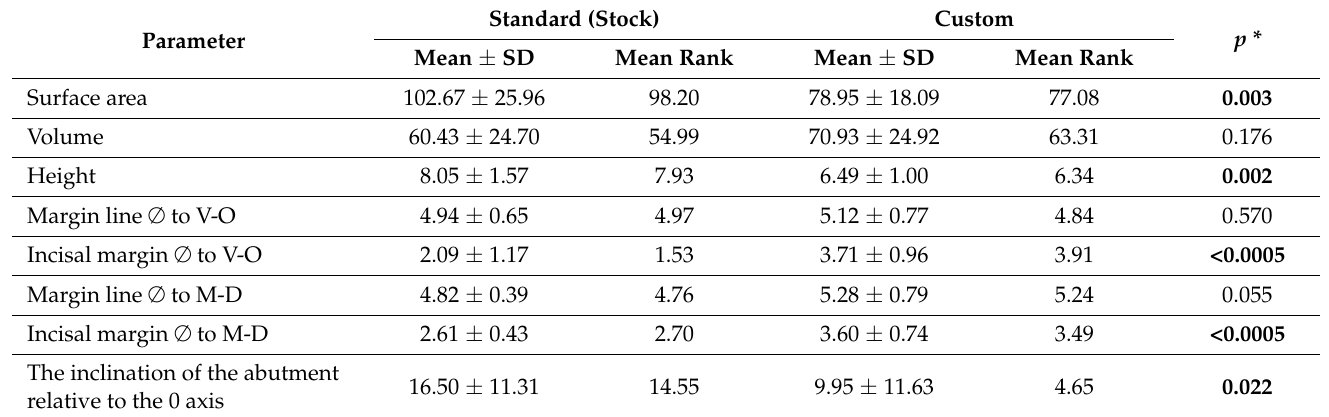
Table 2. Statistical comparisons between stock abutments and custom